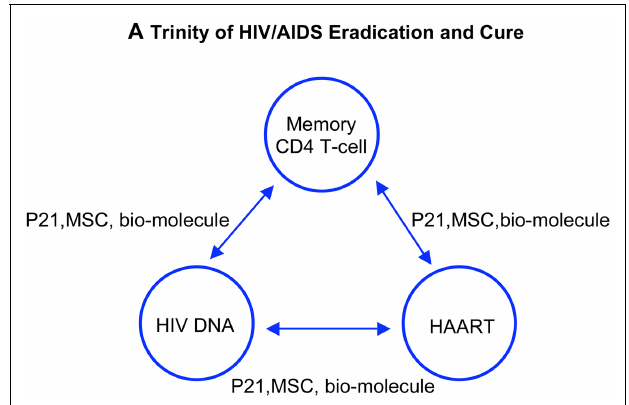
FIGURE 3 | Silencing HIV reservoir via epigenetic machineries . (A) Methylated HERVs are passed for generations without causing retroviral diseases, and a targeted hypermethylation at the DNA sequence of HERVs has been recognized to be the mechanism silencing gene expression of ancient endogenous retroviruses in the human genome (1–11). (B) HIV is a modern example of HERVs. A targeted hypermethylation at the HIV promoter will be possible to genetically and sterilely block HIV RNA expression, mimicking what occurs to HERVs. DNMT3b is the prime